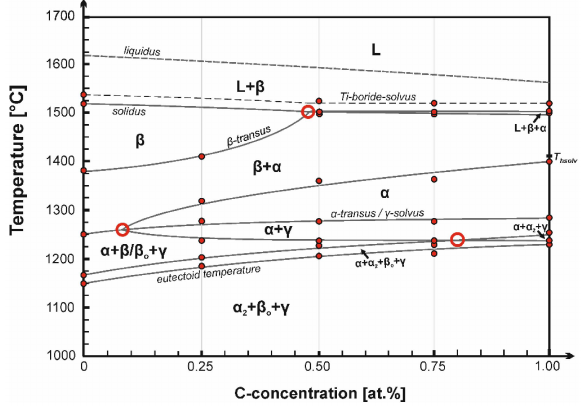
Figure 8. Experimentally-determined quasi-binary section of the TNM-(0–1)C (at. %) system. Evidently, C acts as a strong α stabilizer [38]. (Reprinted from Reference [38], Copyright (2014), with permission from